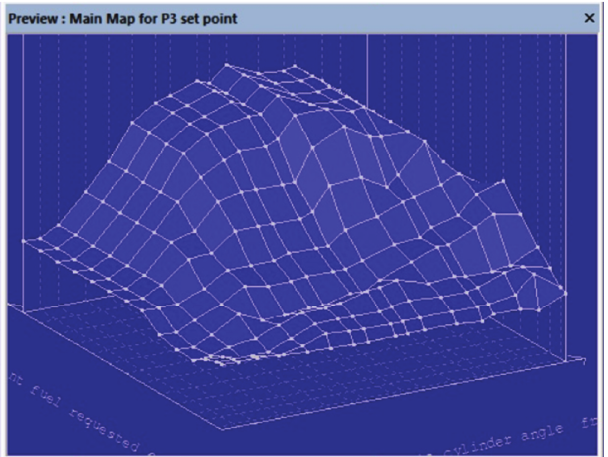
Fig. 2. An example of a „control map” for fuel supply [11]